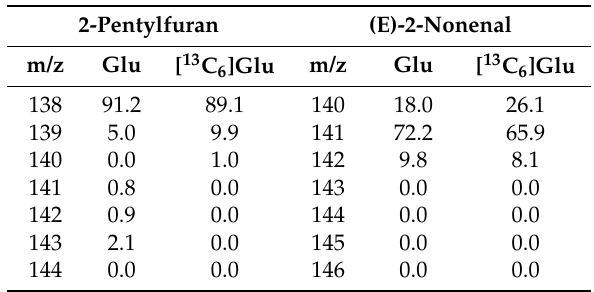
Table 3. Isotope ratios (%) of 2-pentylfuran and (E)-2-nonenal from the reaction of (E)-2-nonenal and glucose or [ 13 C 6 ]glucose, respectively.